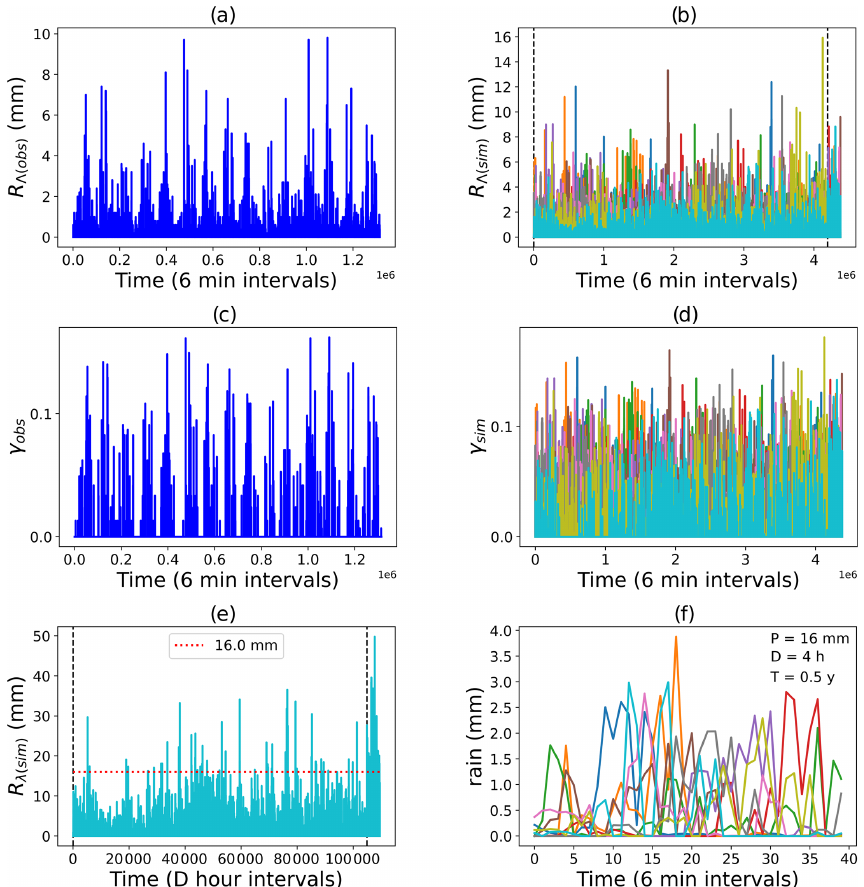
Figure 6. Paris reference rainfall scenarios ( P = 16 mm ,D = 4h ,T = 0 . 5 years). (a) Rainfall and (c) corresponding singularities from observational dataset PD3. (b) Rainfall, (d) corresponding singularities, (e) aggregated rainfall from member m10 and (f) events with 16mm cumulative rainfall of 4h duration from the ensemble double-cascade